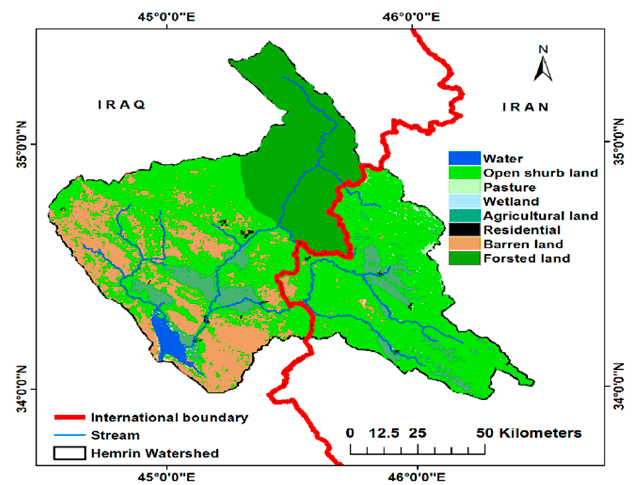
Figure 20. Senario-1 (M-1) of sediment mitigation in the Hemrin Watershed.